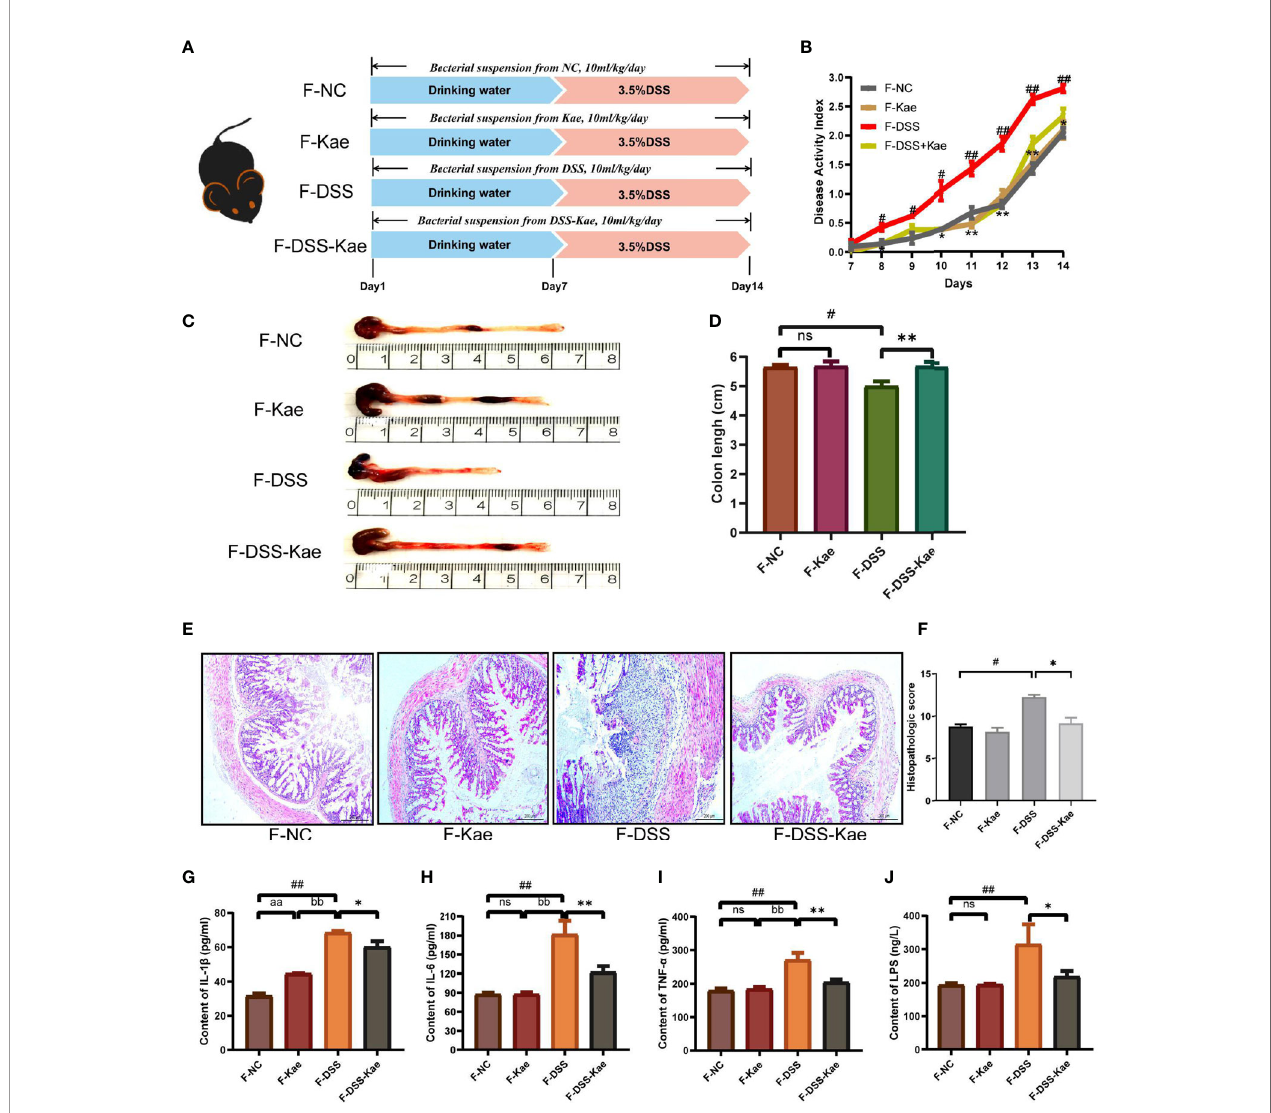
FIGURE 8 | Transplantation of microbiota altered in response to Kae recapitulates the effects of Kae treatment on DSS-induced colitis. (A) Design of the FMT experiment on DSS-treated mice (n = 10/group). (B) Disease activity index of FMT mice during the course of colitis. (C, D) Representative images of mouse colon at sacri fi ce and statistical analysis of colon length data from each FMT group. (E, F) Representative images of H&E staining of colon samples (scale bar, 200 m m) and histological scores of colonic tissues. Serum in fl ammatory factors: (G) IL-1 b , (H) IL-6, and (I) TNF- a were measured using ELISA kits. (J) Serum LPS levels indicate the endotoxemia index. Data are expressed as the mean ± SEM, n = 4 – 10, analyzed using one-way ANOVA with Tukey post-hoc analysis. DSS ( vs . NC, # P < 0.05; ## P < 0.01; vs . DSS-Kae, * P < 0.05, ** P < 0.01); F-Kae ( vs . F-NC, aa P < 0.01); F-Kae ( vs . F-DSS, bb P < 0.01); ns, no signi fi cant